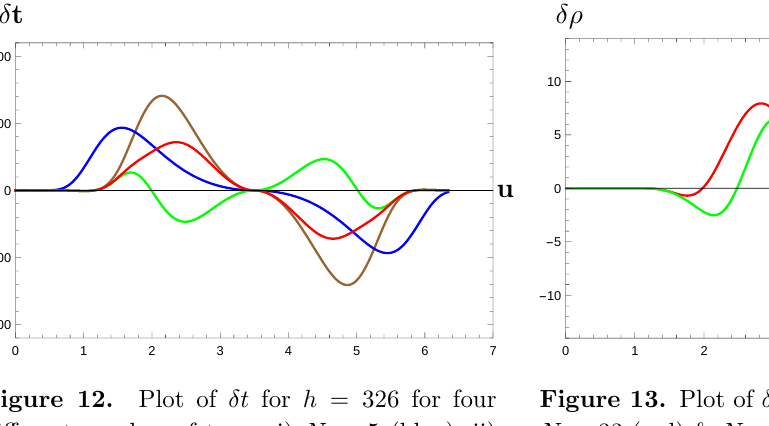
Figure 12. Plot of (cid:14)t for h = 326 for four di(cid:11)erent number of terms i) N = 5 (blue), ii) N = 21 (brown), iii) N = 33 (green) & iv) N = 43 (red).